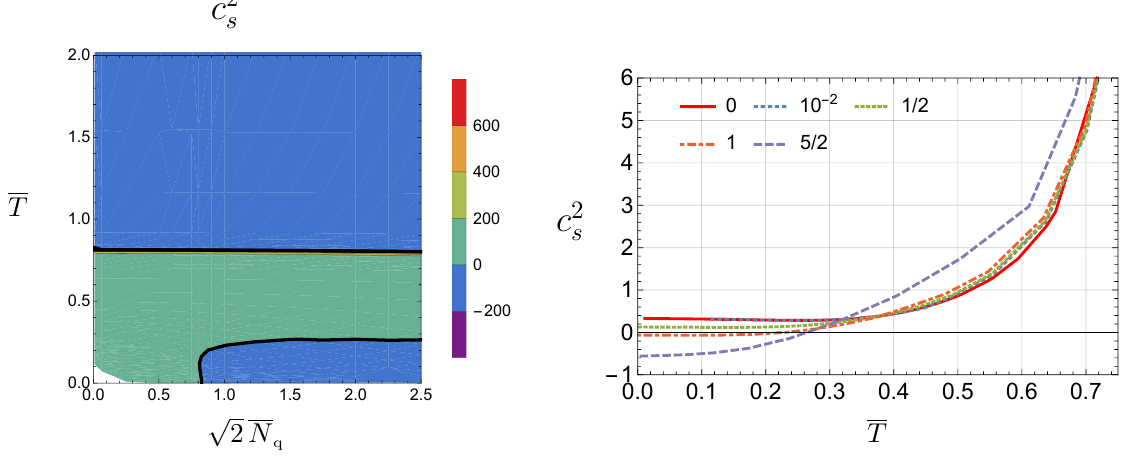
Figure 17. (Left) Contour plot of the speed of sound squared. The thick, black, continuous curve indicates the locus where c 2 changes sign. (Right) Plots of the speed of sound as a function of s p temperature for several (cid:12)xed values of the charge density 2 N . The speed of sound diverges q towards positive (negative) in(cid:12)nity as the upper black curve is approached from below (above). This is why the scale of the contour plot has such a large range.